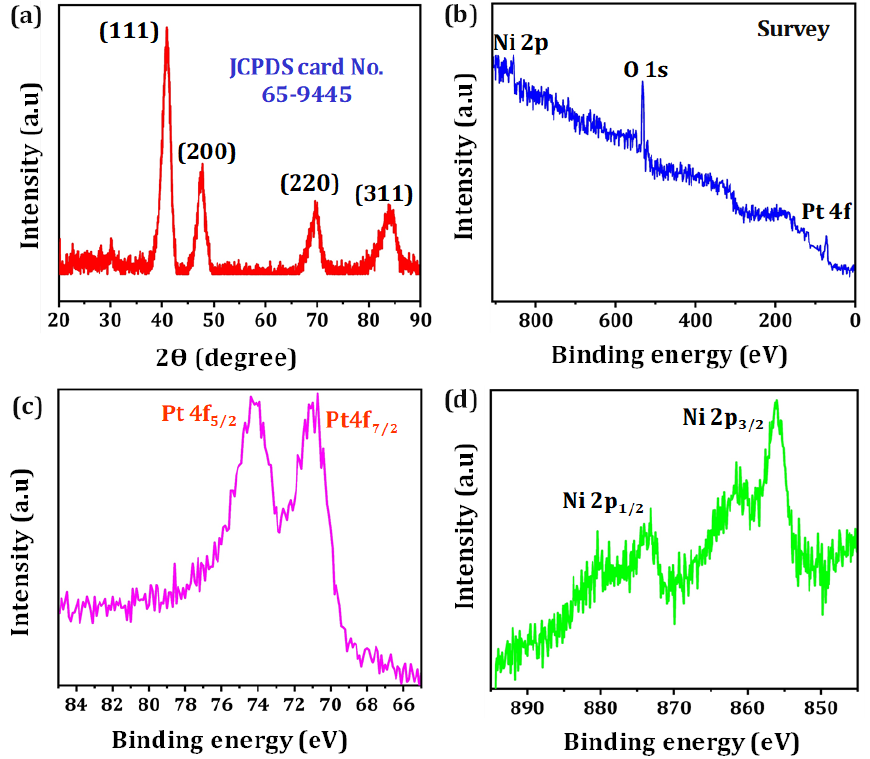
Figure 1. ( a ) XRD pattern of PtNi NPs, ( b ) survey spectrum of PtNi NPs, magnified XPS profiles of ( c ) Pt 4f and ( d ) Ni 2p. ( c ) Pt 4f and ( d ) Ni